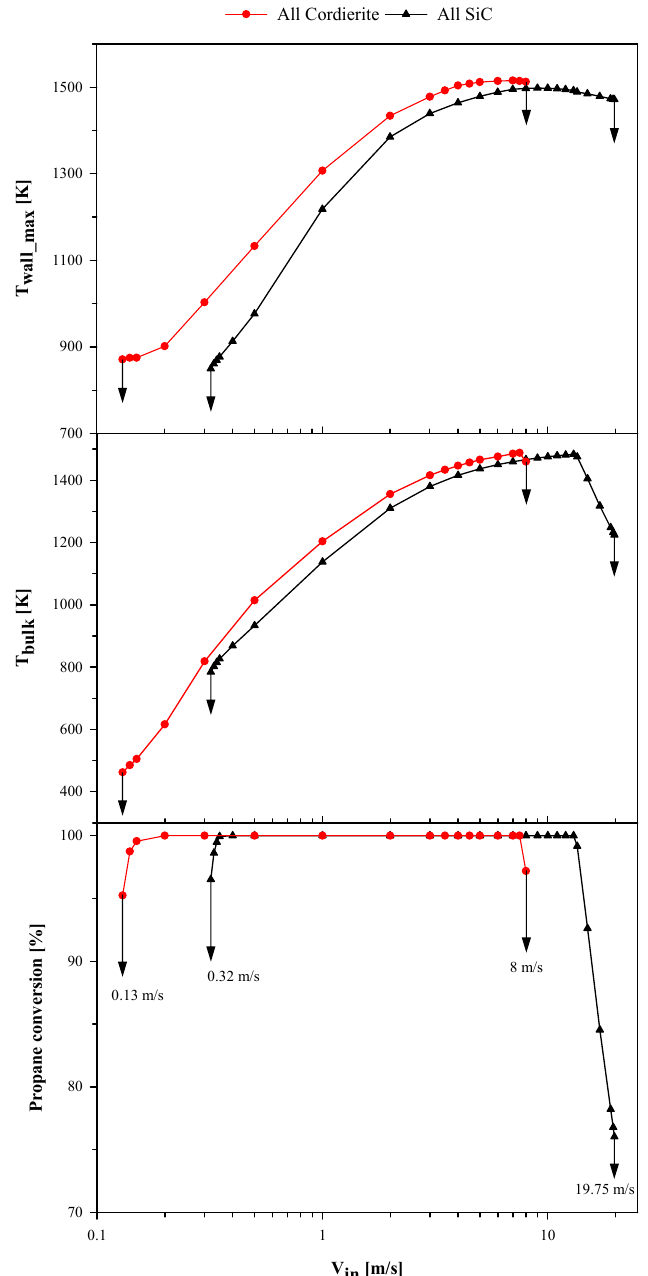
Figure 5. Maximum wall temperature, T wall_max , (outlet) bulk gas temperature, T bulk , and (outlet) propane conversion versus V in : All Cordierite and All SiC. Arrows indicate extinction (at low values of V in ) and blowout (at high values of V in ).